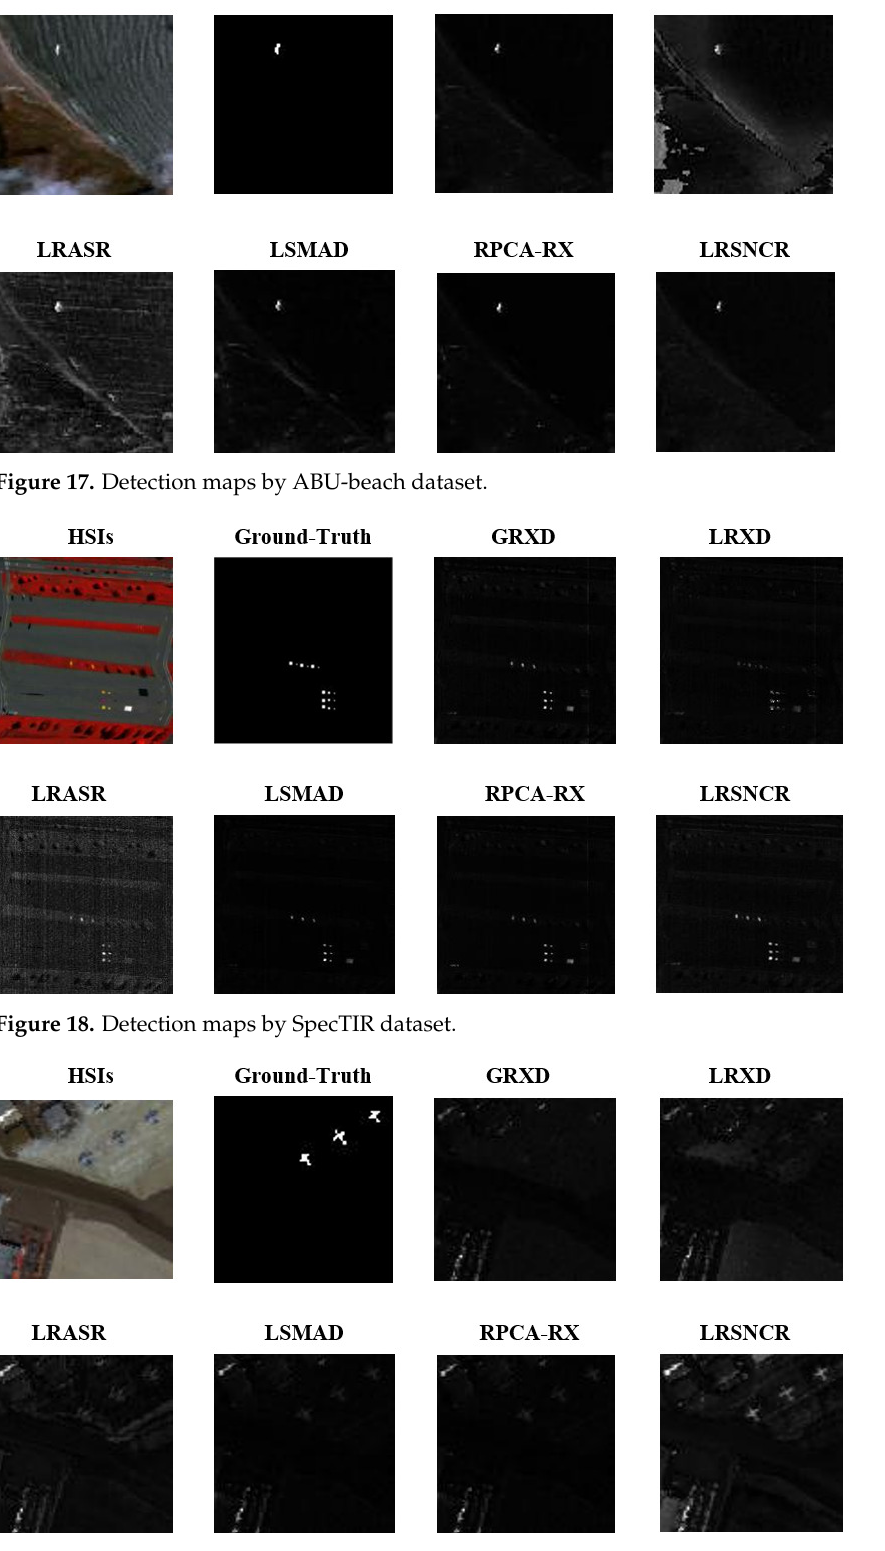
Figure 19. Detection maps by Sandiego